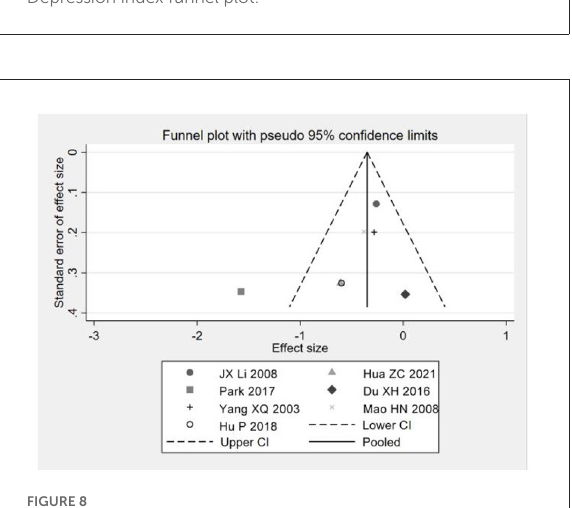
FIGURE8 Anxiety index funnel